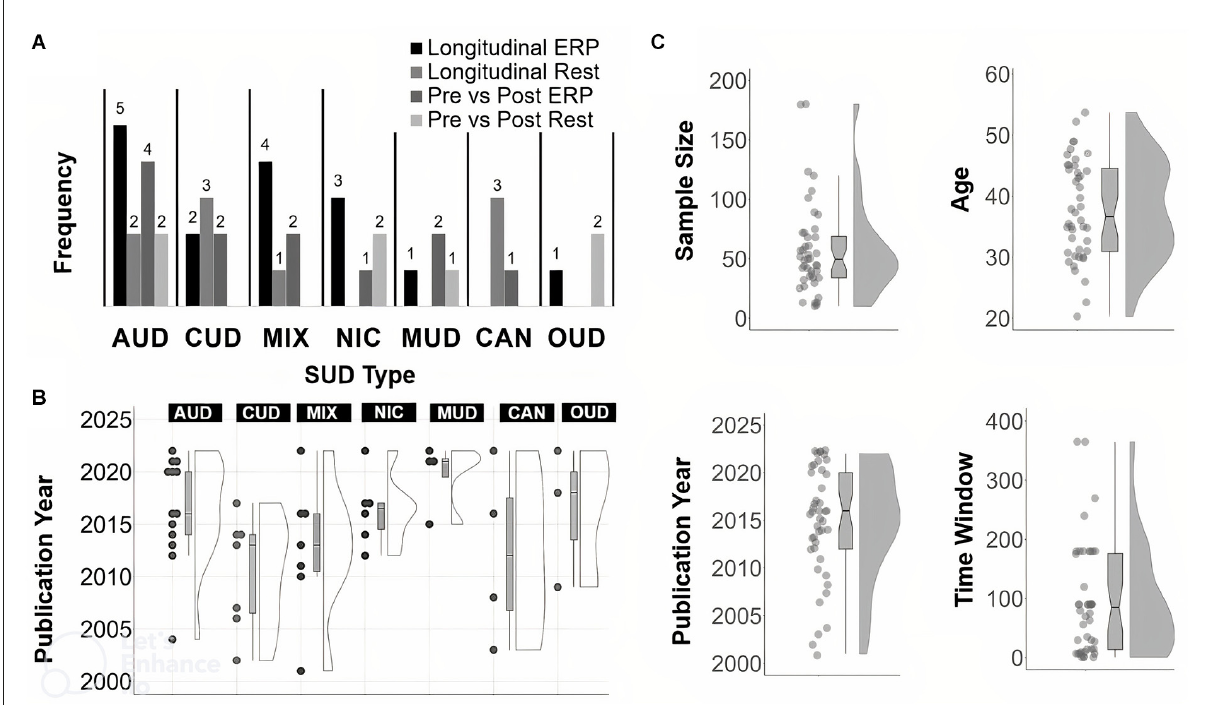
FIGURE2 Summary of article features. Frequency count for each SUD type (A) , SUD type by year (B) , and, distribution and boxplot (C) of sample size, year, Time 1 to Time 2 in days, year of publication and age. For Time 2 assessments done the same day or session, the Time to Time 2 value for those studies was set to 1